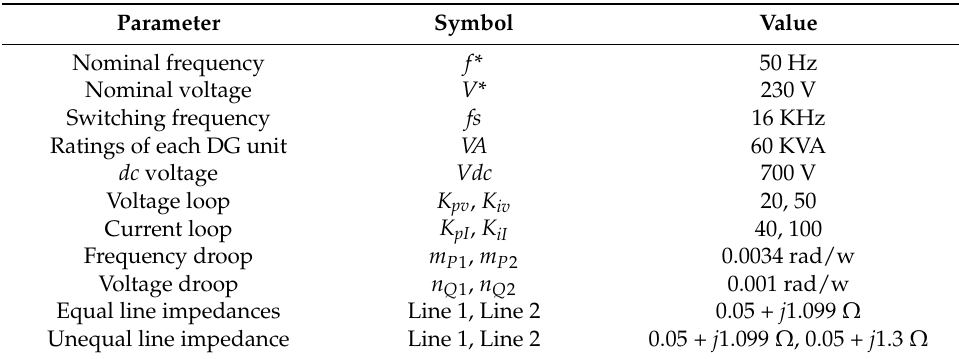
Table 2. System and controller parameters.